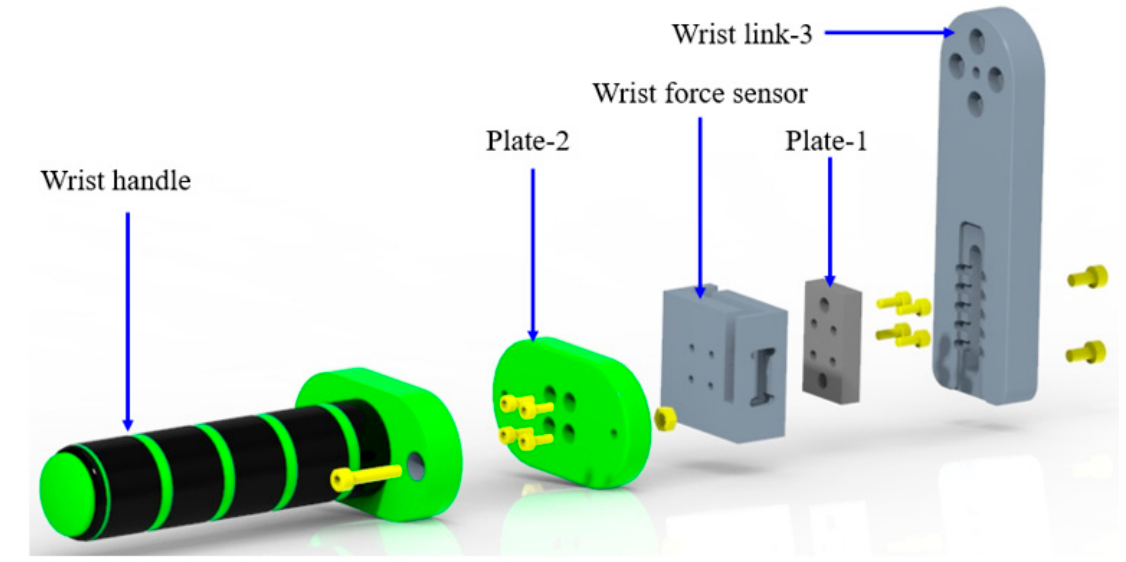
Figure 12. Exploded view of the integration of the wrist force sensor into the proposed exoskeleton robot.